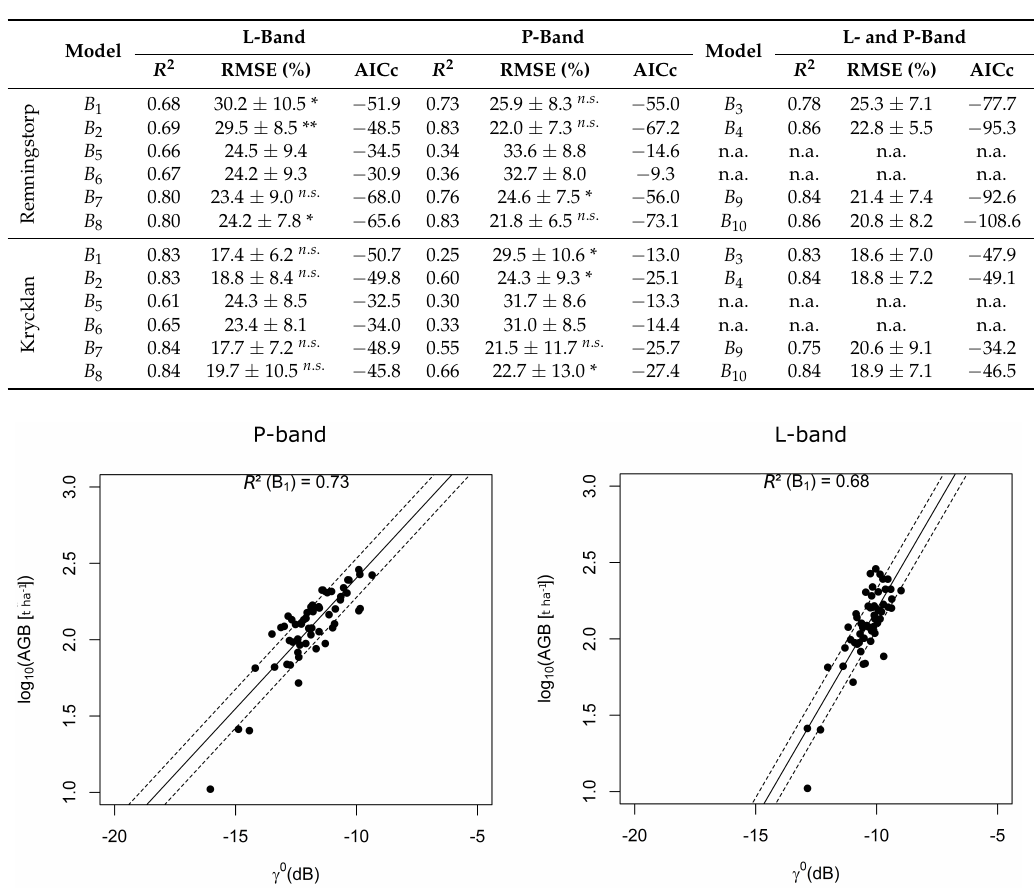
Table 3. Coefficient of determination R 2 , RMSE and AICc for different aboveground biomass estimation models (see Section 3.3 for the used predictors in each model). Each row corresponds to the same model applied to each frequency separately (first 7 columns) and then to both frequencies (last 4 columns). The standard deviation of the 10-fold cross-validated RMSE is provided ( ± ) and n.a. means not applicable e.g., no corresponding dual-frequency version of the model. Significance of difference between single-band RMSE and corresponding combined RMSE (indicated in the same row of the table) is presented as * for a p -value < 0.05, ** < 0.01 and *** < 0.001; n.s. means not significant with significance level α of 0.05. Remningstorp results are based on acquisitions on 2 May 2007 and Kryckland results are based on 313 ◦ heading.